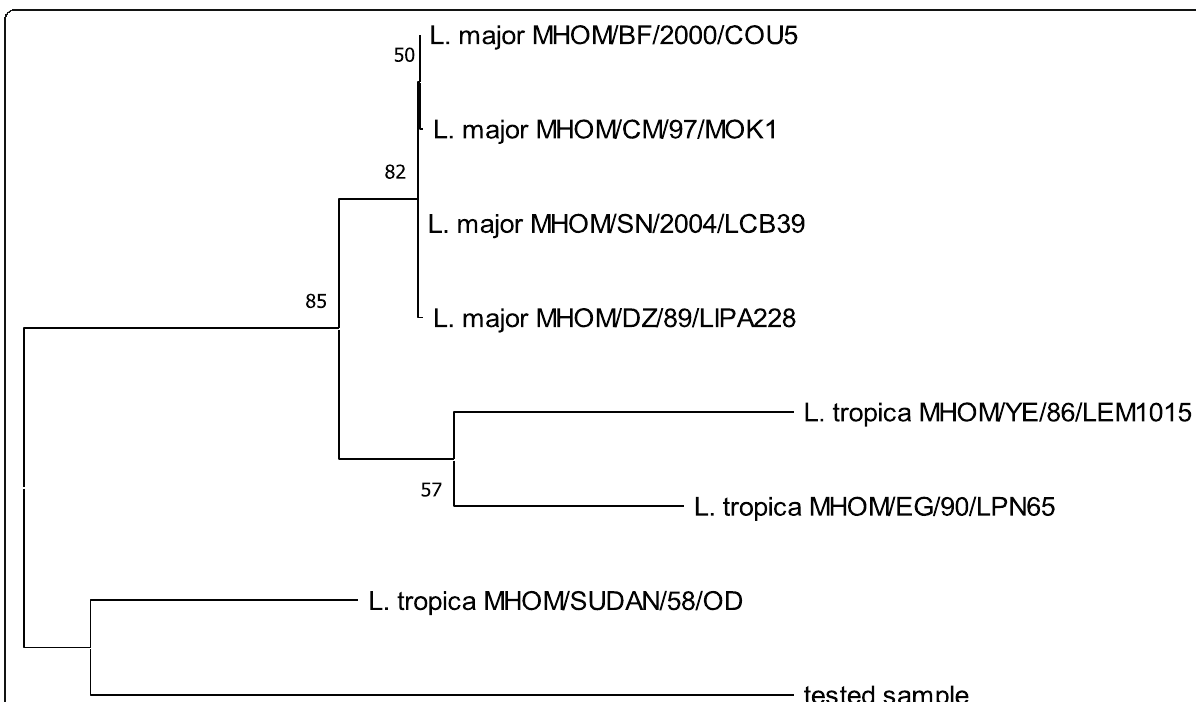
Fig. 4 The phylogenetic tree. The phylogenetic tree was constructed based on the 368-nt nucleotide sequences by the maximum likelihood method and Kimura 2-parameter